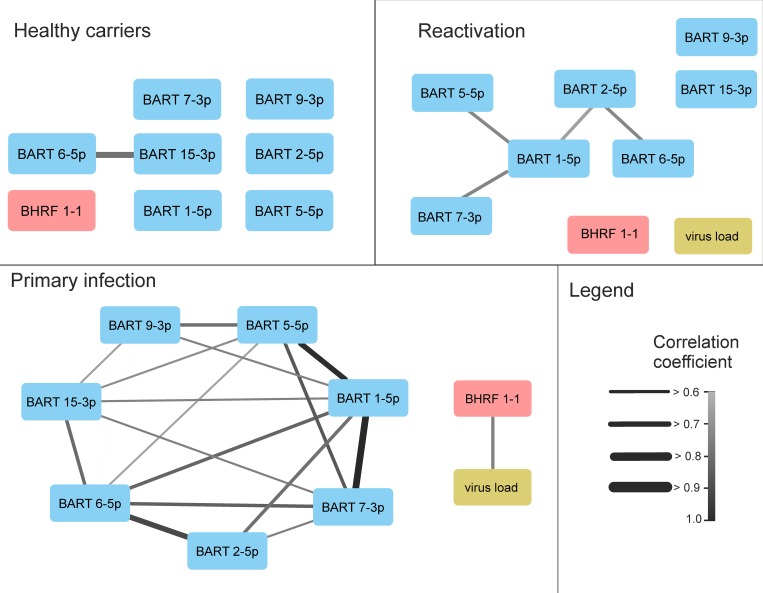
Pairwise correlations of the miRNAs and viral load in the different patient groups.The grey scale as well as the line sizes correspond to the respective Spearman correlation coefficient (rs).